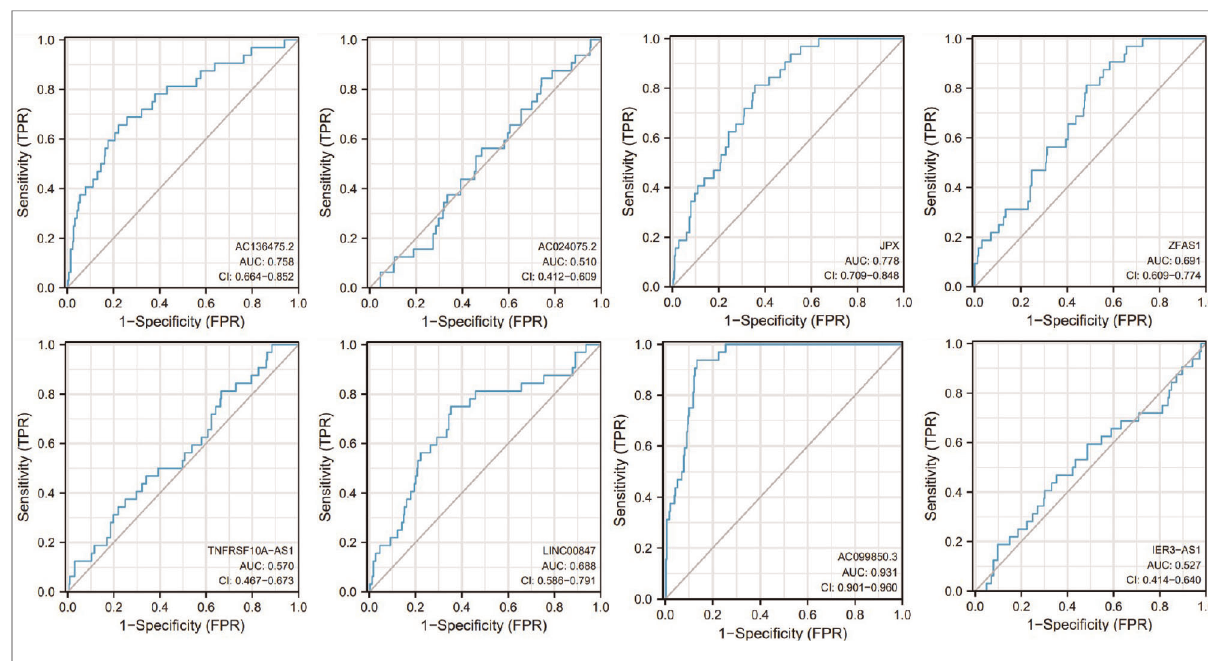
FIGURE 9 Receiver operating characteristic curves (ROC) for the AC136475.2, AC024075.2, JPX, ZFAS1, TNFRSF10A-AS1, LINC00847, AC099850.3, IER3-AS in the patients with oral squamous cell carcinoma. AUC, area under the